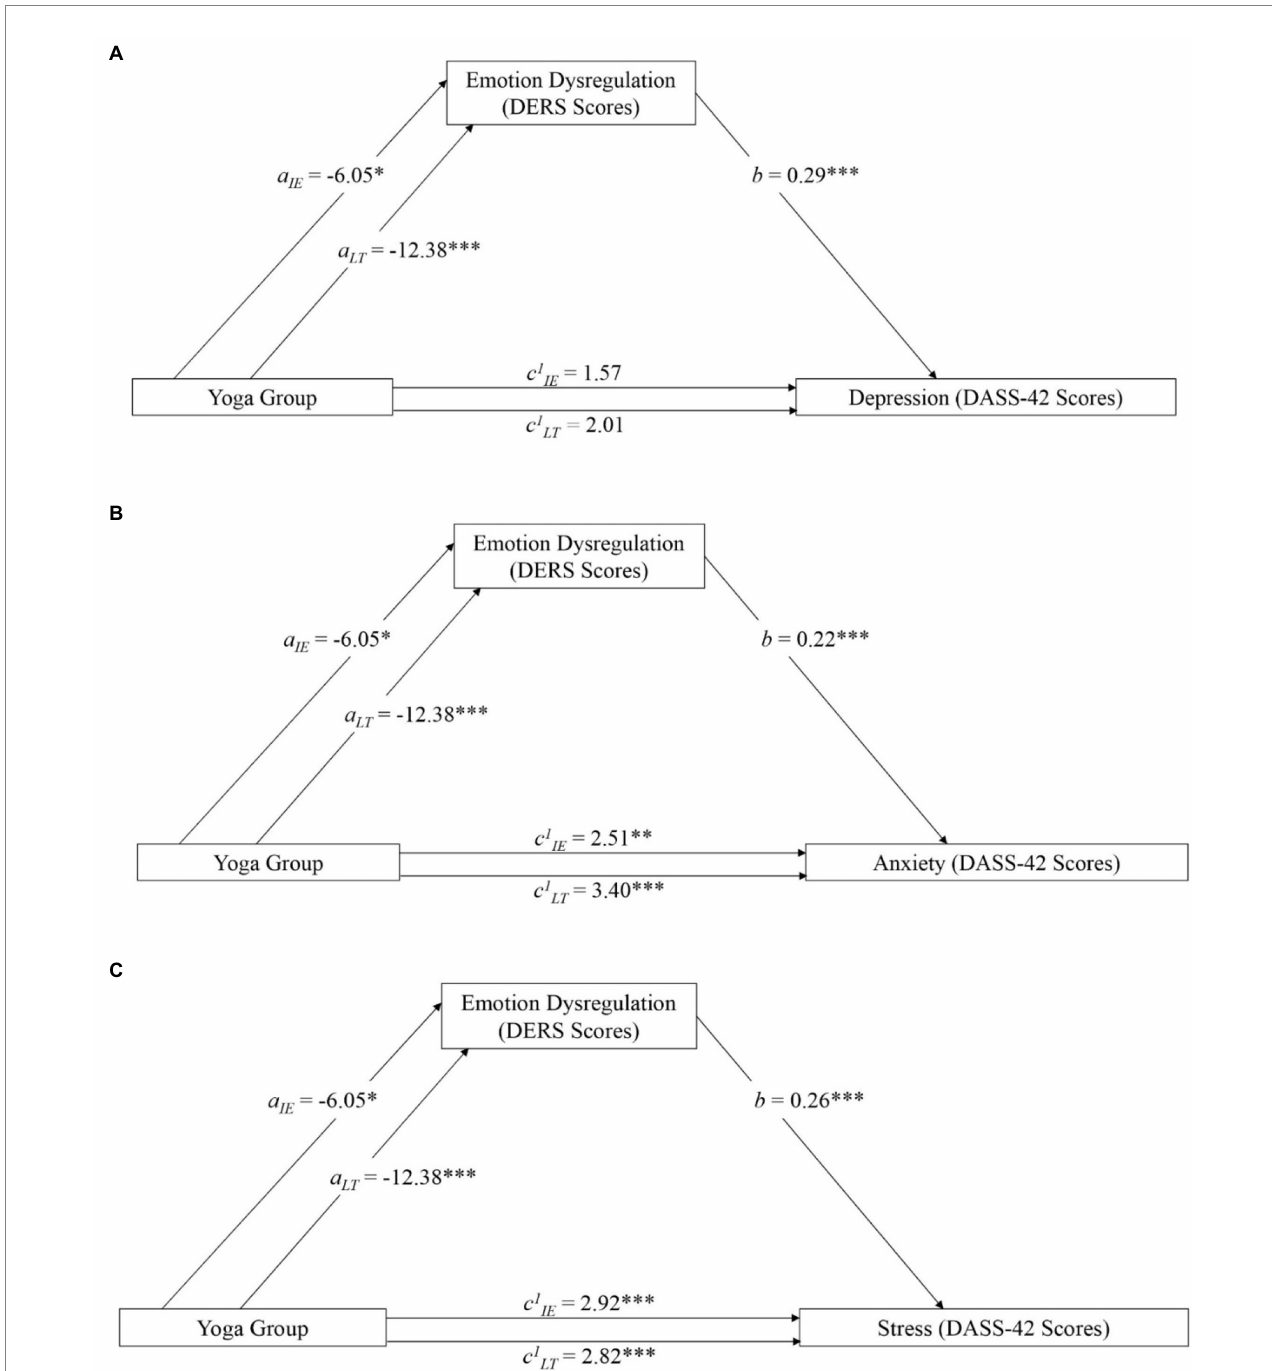
FIGURE 4 Mediation model featuring yoga practice (predictor), emotion dysregulation (mediator), and depression (A) , anxiety (B) , and stress ( C ; outcomes). Variables with subscript IE represent a comparison between the no experience and intermittent experience (IE) group. Subscript LT represents a comparison between the no experience and the long-term (LT) group. Significance is represented with * ( p < 0.05), ** ( p < 0.01), or *** ( p <